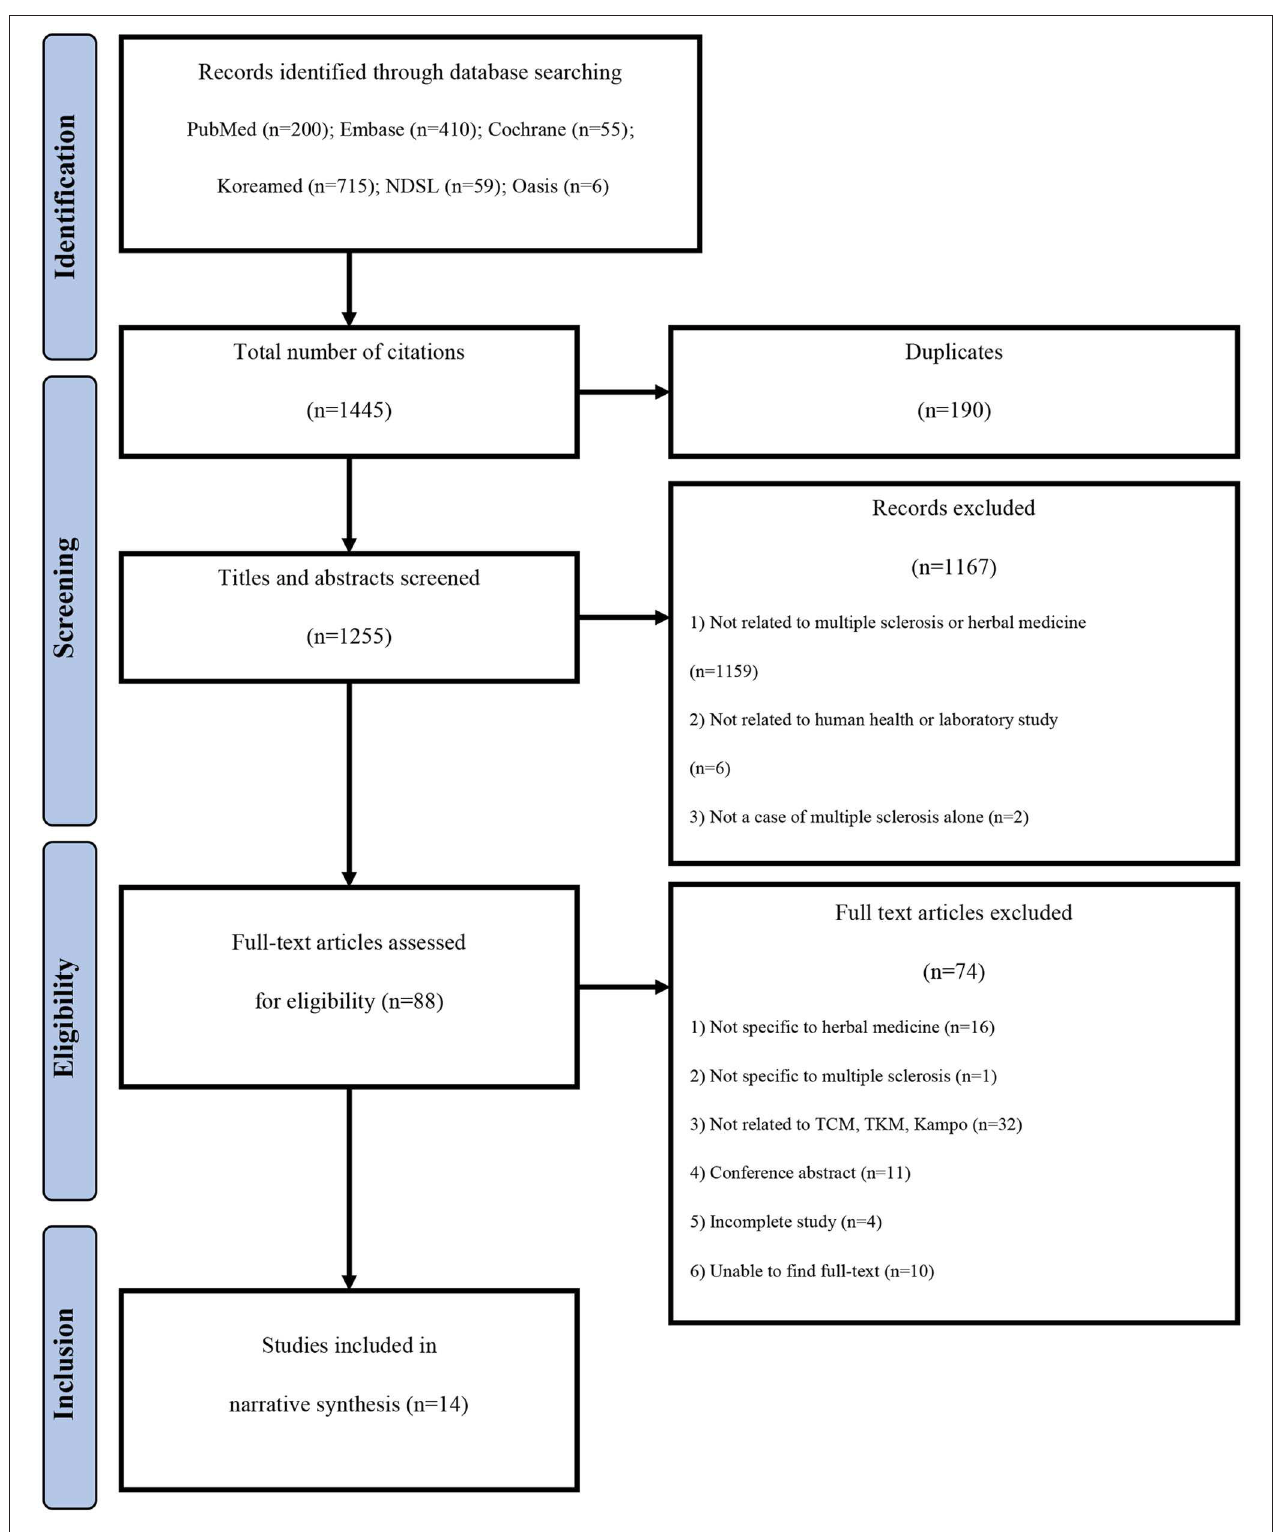
FIGURE 1 | Study flow chart. TCM, Traditional Chinese Medicine; TKM, Traditional Korean Medicine.